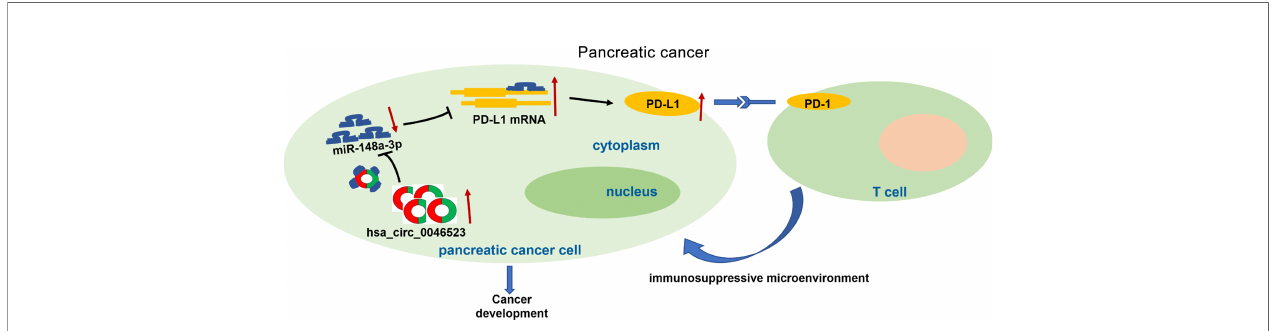
FIGURE 9 | The schematic illustration of the potential molecular mechanism of hsa_circ_0046523 as a key regulator tumor immune microenvironment of PC. Hsa_circ_0046523 was remarkably upregulated in PC, and upregulated PD-L1 expression by sponging miR-148a-3p, which activating the PD-1/PD-L1 pathway, inducing the formation of immunosuppressive microenvironment of PC, and ultimately promoting the progression